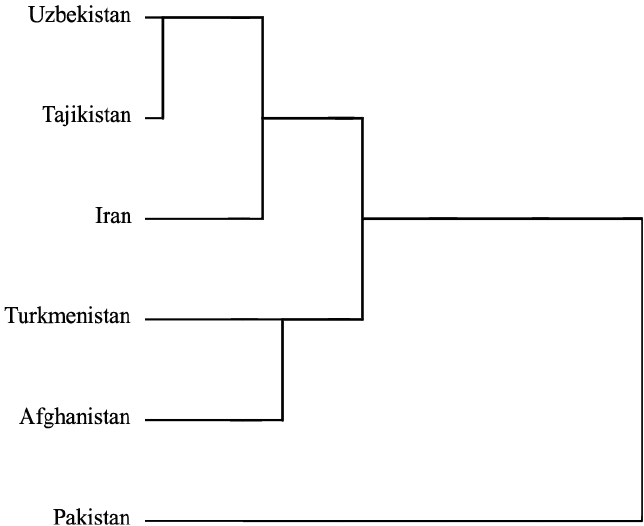
F IGURE 3. Jaccard’s similarity dendrogram for earthworm fauna comparison between Afghanistan and neighbouring